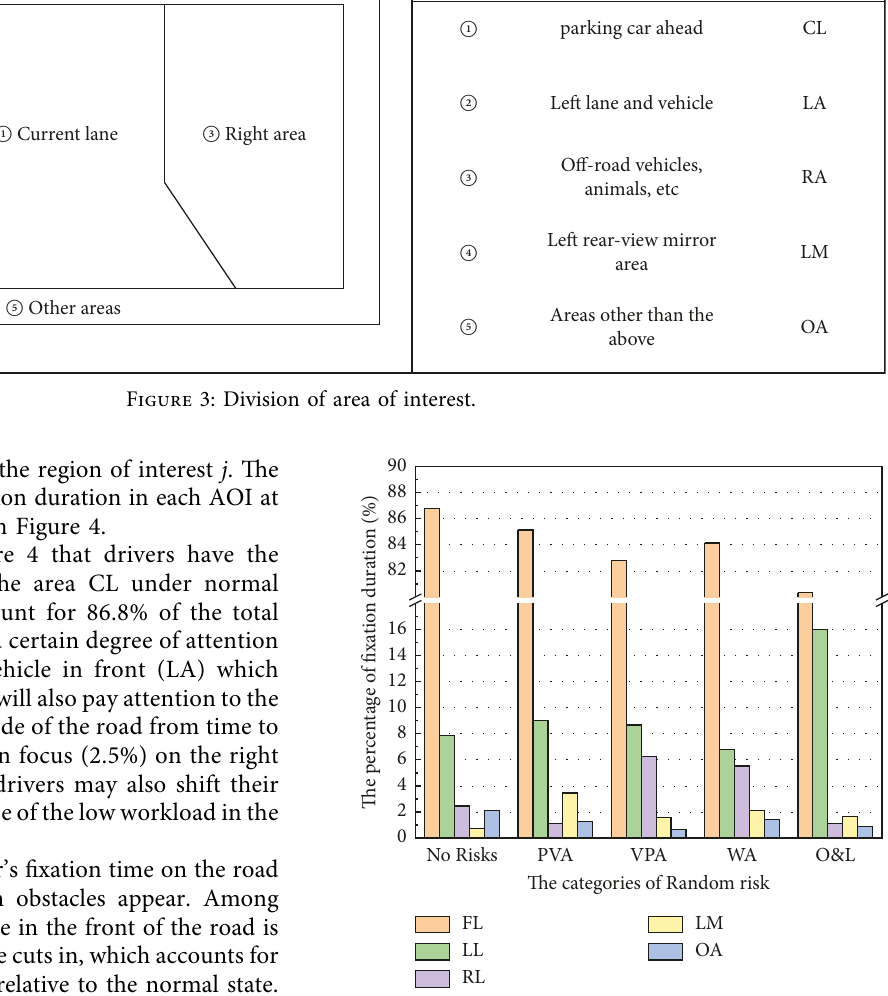
Figure 4: Percentage of fixation duration in each AOI at different risk